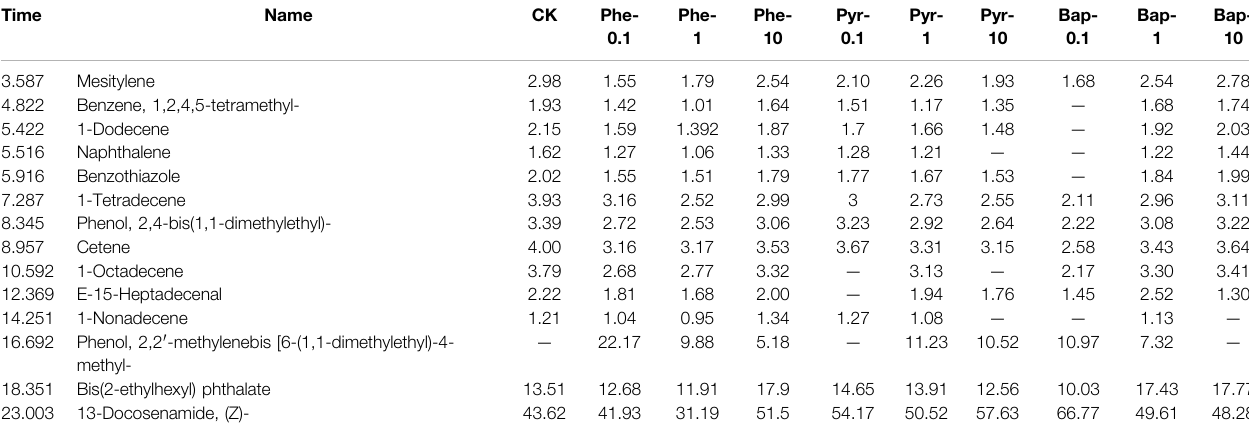
TABLE 1 | GC-MS measurement results of composition and relative content of root exudates after15 days PAHs hydroponic stress.